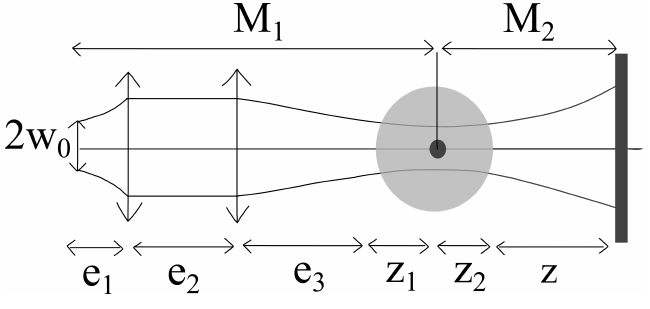
Figure 7. Experimental set-up for the reconstruction of droplet’s inclusions.